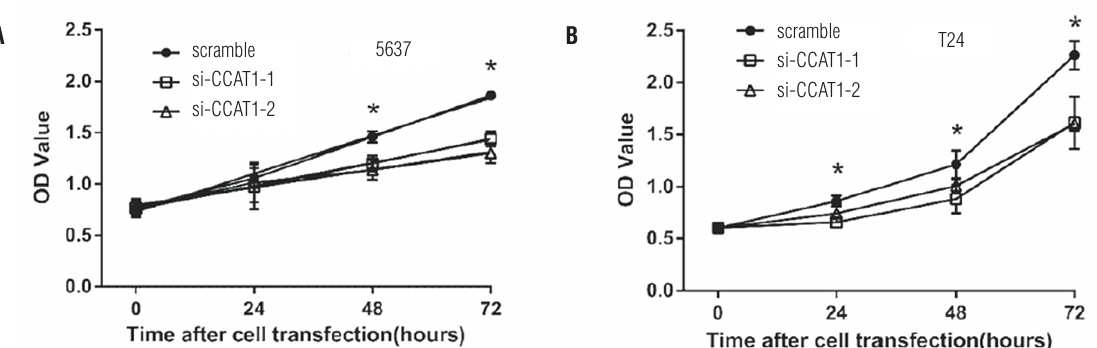
Figure 3 - Effects of CCAT1 on proliferation in 5637 and T24 cell lines. CCK-8 cell proliferation assays show that CCAT1 knock- down significantly weakened proliferation in 5637 and T24 cells.